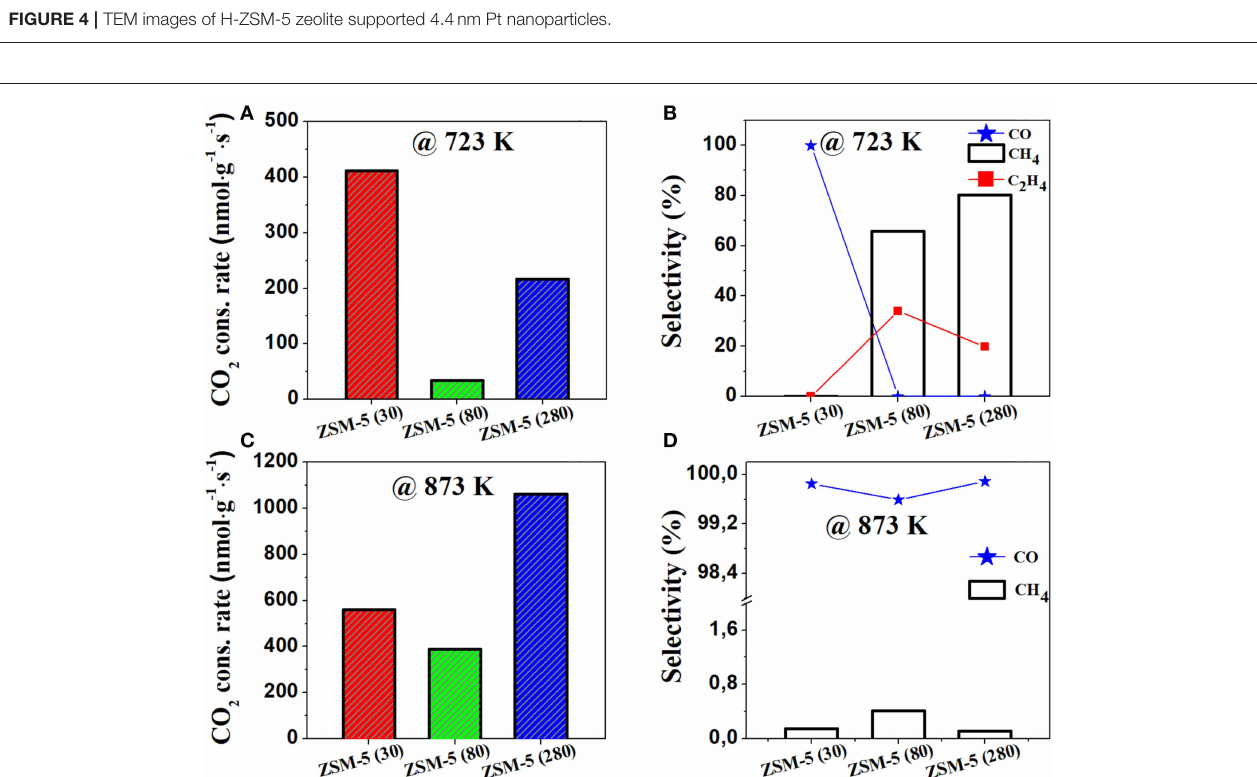
FIGURE 5 | CO 2 consumption rate and distribution of products at 723 and 873K over Pt-free, H-ZSM-5 zeolites. (A) CO 2 consumption rate at 723K, (B) Selectivity at 723K (C) CO 2 consumption rate at 873K, (D) Selectivity at